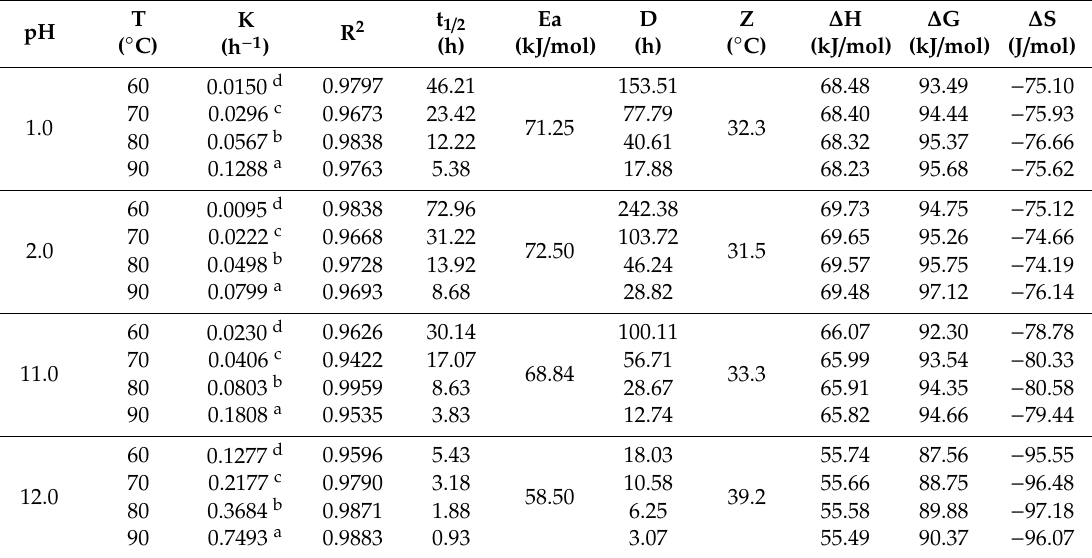
Table 1. Kinetic parameters of Neu5Ac at pH 1.0, 2.0, 11.0 and